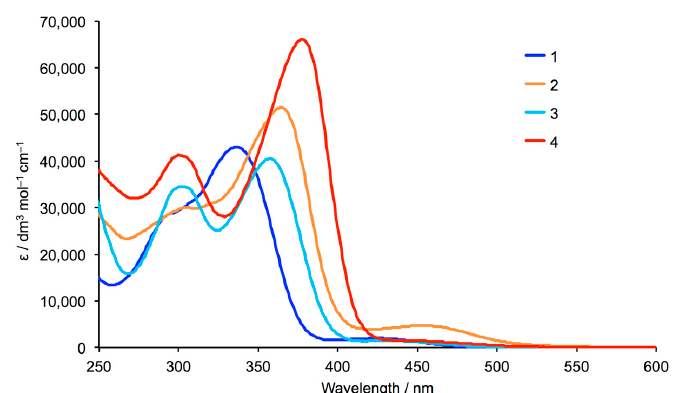
Figure 1. Solution absorption spectra of 1 – 4 (CHCl 3 , concentrations 2.1–2.6 × 10 − 5 mol dm − 3 ).